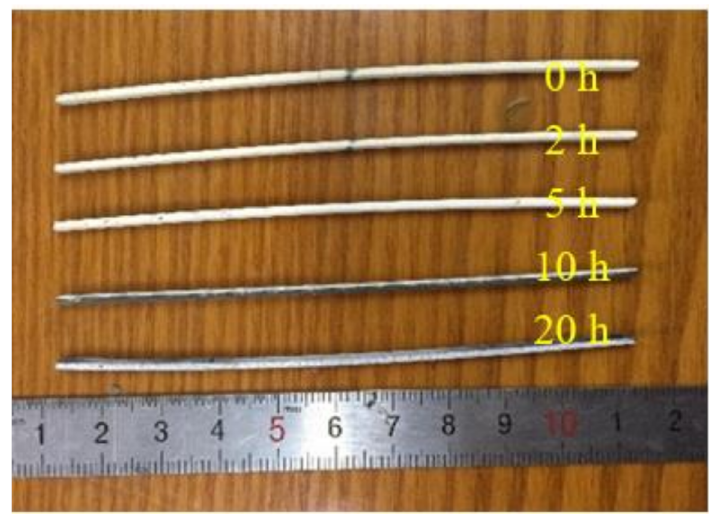
Figure 4. Specimens after thermal loading.